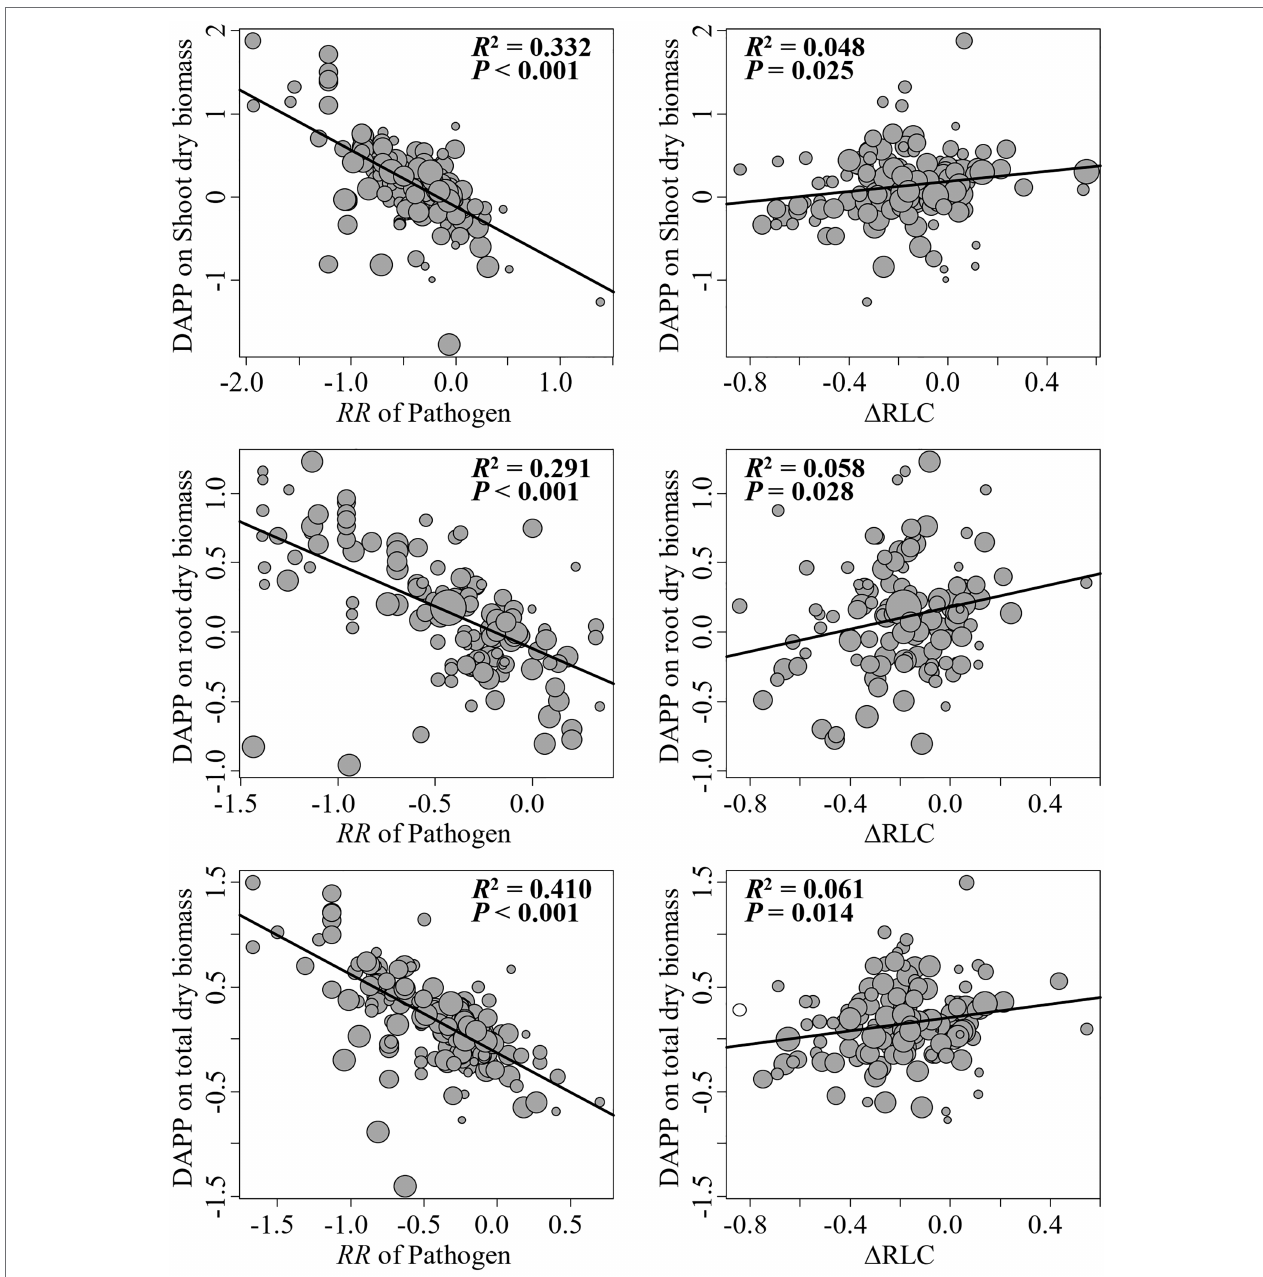
FIGURE 5 | Linear relationships between the effect size difference of AMF on the plant dry biomass under plant pathogenic microbes and no-pathogenic conditions (DAPP) with ∆ RLC and effect of plant pathogenic on plant biomass. Significance test for the linear relationship was based on a mixed-effects model with a REML method and values of p ≤ 0.05 were significant. The point size is proportional to the weight of each observation in model. N means the number of